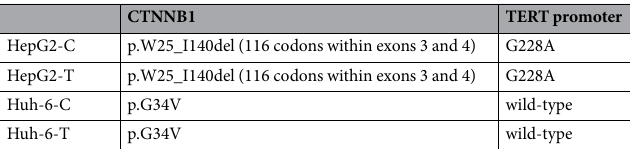
Table 1. Mutation analysis of HB cell lines and xenograft samples. Two parental cell lines are HepG2-C and Huh-6-C; two cell lines grown in vivo as xenograft tumors are HepG2-T and